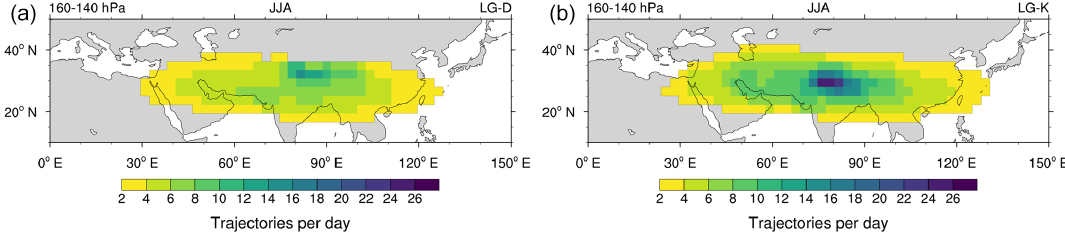
Figure B1. Starting frequency of trajectories for LG-D (a) and LG-K (b) over the years 1981–2010. For LG-K, data for 2008 were removed; see text for details.